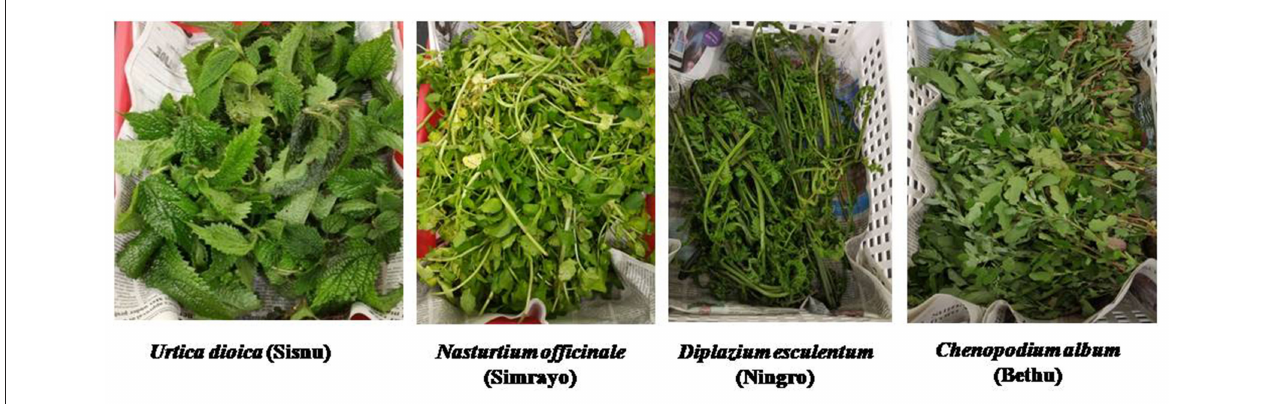
FIGURE 1 | Selected green leafy vegetables popularly consumed in the Sikkim Himalayan region.